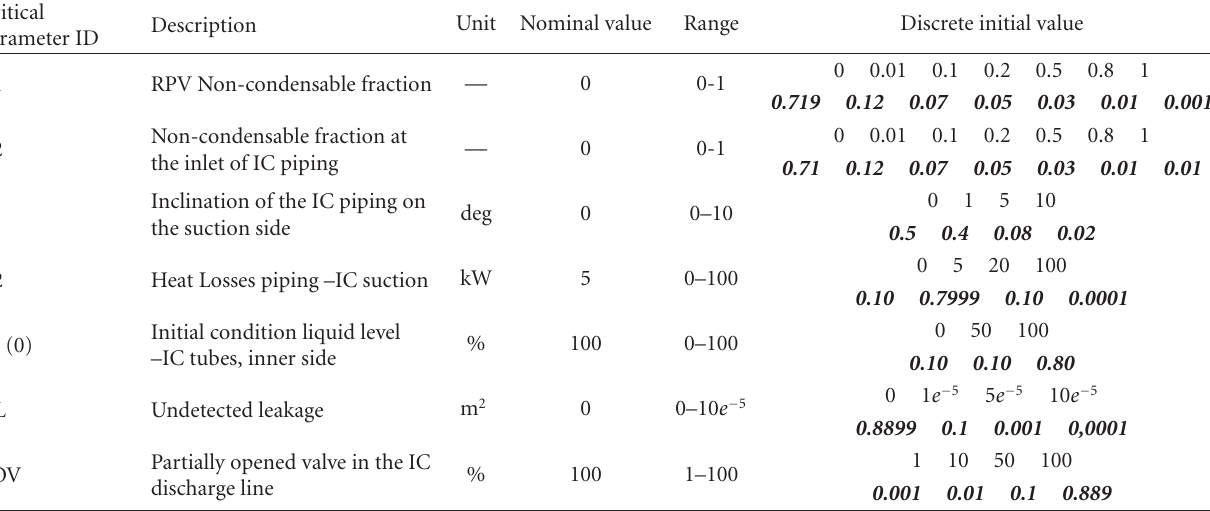
Table 4: Critical parameters case